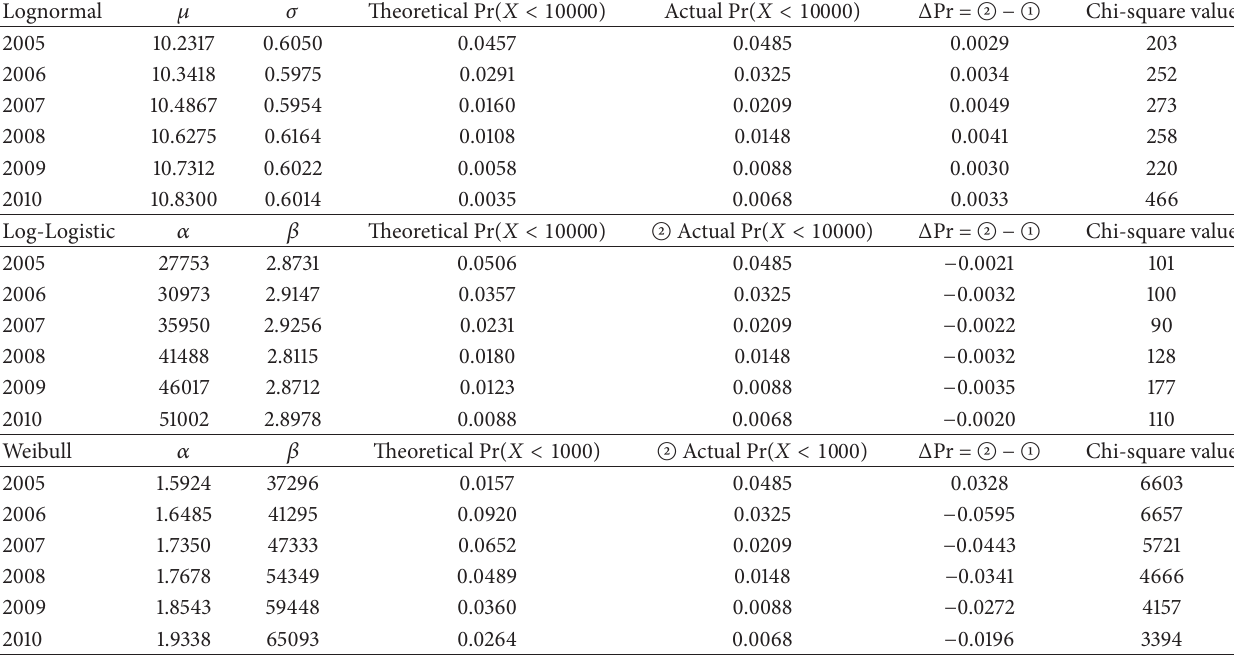
Table 5: Parameter evaluation and goodness of fittest of three Distribution